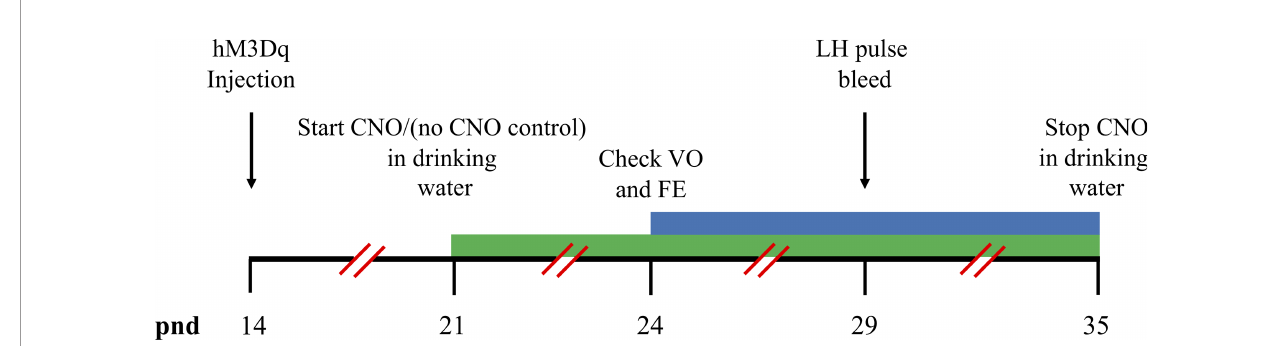
FIGURE 2 | Timeline schematics for the effect of hM3Dq activation of MePD Ucn3 neurons on pubertal timing and pre-pubertal LH pulse frequency. Time in post-natal days (pnd) is indicated by the black horizontal line. Ucn3-cre-tdTomato female mice were injected with AAV5-hSyn-DIO-HA-hM3D(Gq)-IRES-mCitrine (hM3Dq) on pnd 14. Clozapine-N-oxide (CNO) was administered in drinking water on pnd 21 and lasted for 14 days until pnd 35 (green bar). The mice were monitored for the onset of vaginal opening (VO) and fi rst estrous (FE) from pnd 24 (blue bar). Pre-pubertal pulsatile luteinising hormone (LH) secretion was tested on pnd 29 (black